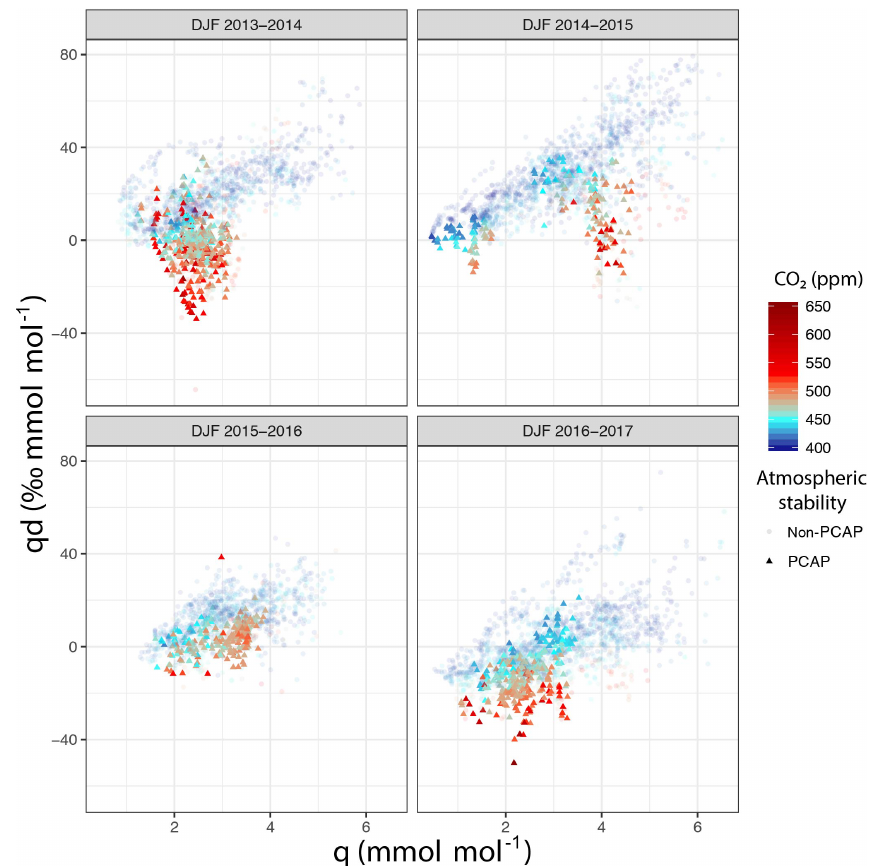
Figure 4. Relationship of the product of specific humidity and d-excess, qd (‰mmolmol − 1 ), against specific humidity q (mmolmol − 1 ). Points are colored by CO 2 concentration (ppm) at the time of measurement, with the shape and opacity corresponding to whether the data point was collected during a PCAP event (opaque triangles) or outside of a PCAP event (semitransparent circles). Moistening and drying by condensation and mixing of natural air masses occurs along a line with a positive slope, while moistening by CDV occurs along a line with a negative